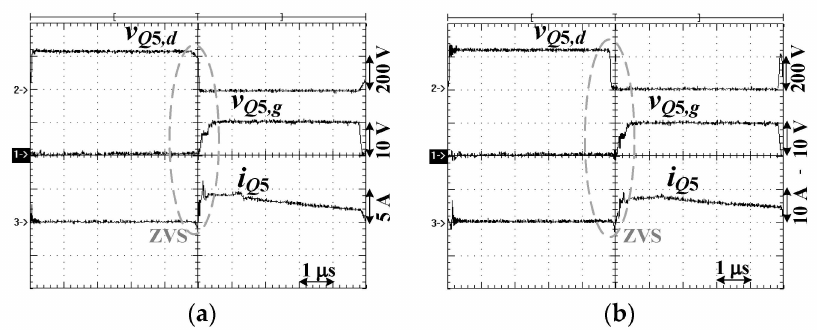
Figure 11. Experimental waveforms of Q 3 at ( a ) V in = 30 V and 50% load and ( b ) V in = 30 V and 100% load.